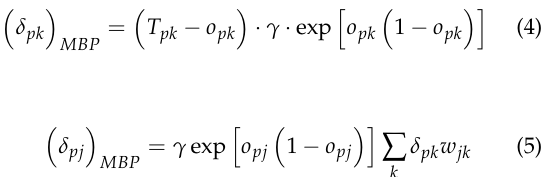
algorithm with BP algorithm, and using calibration heuris- tic algorithm to optimize the BP algorithm; introducing random search algorithm into BP network, combining BP neural network with artificial immune algorithm, evolu- tionary computation, genetic algorithm and ant colony